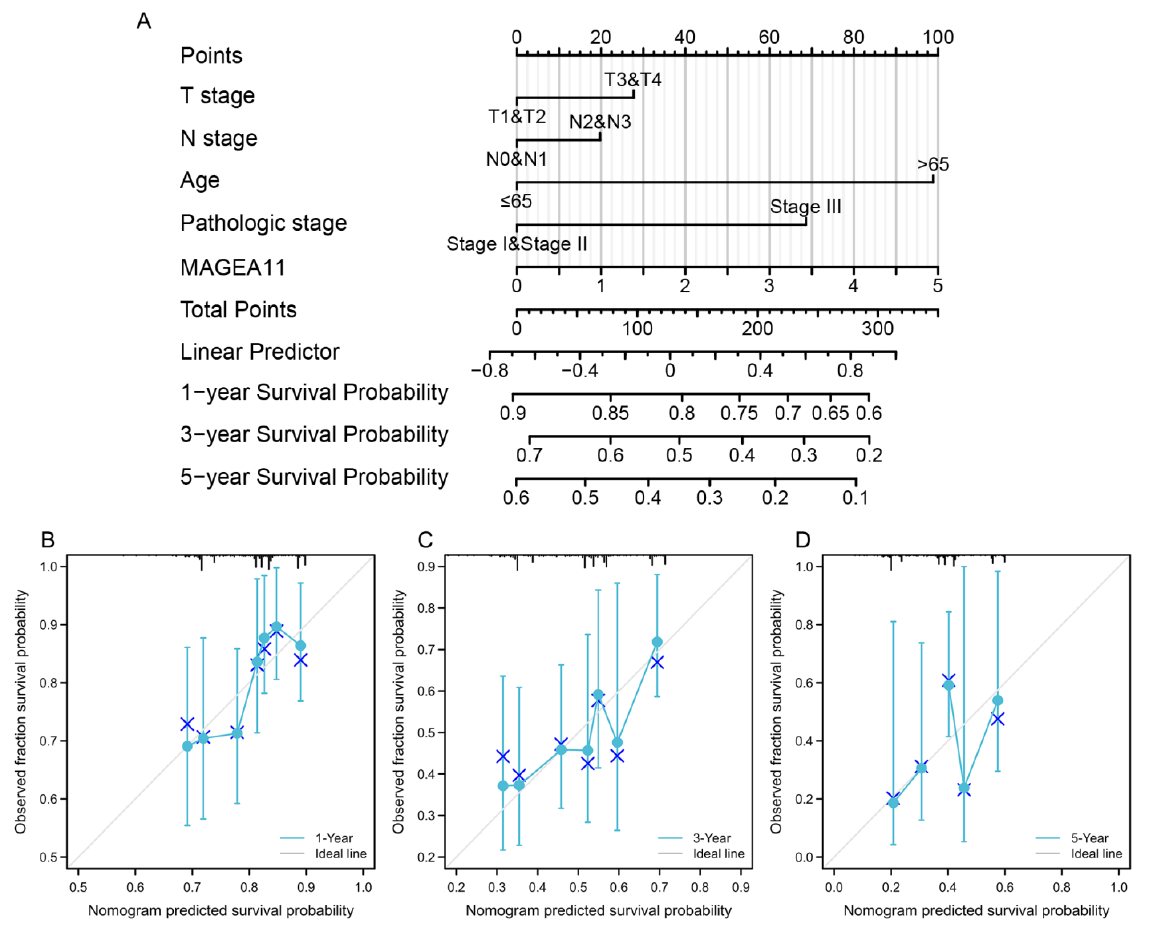
Figure 4. A nomogram was constructed to predict the survival probability of STAD patients. ( A ) Nomogram for predicting 1-, 3-, and 5-year STAD survival probability, including MAGEA11 and clinical risk factors. ( B – D ) Calibration curves of the nomogram predicting OS in patients with STAD. Calibration curves of the nomogram predict 1-year ( B ), 3-year ( C ), and 5-year ( D ) OS in patients with